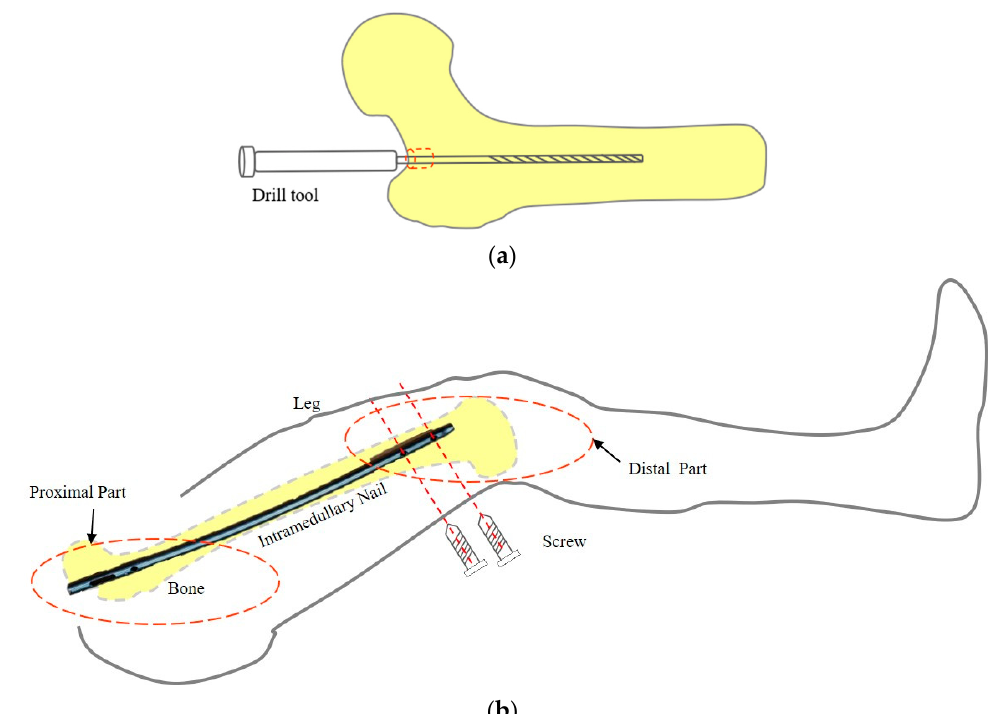
Figure 1. Concept on distal screwing. ( a ) Window-making for insertion of a guide wire. ( b ) Distal fixation with screws.